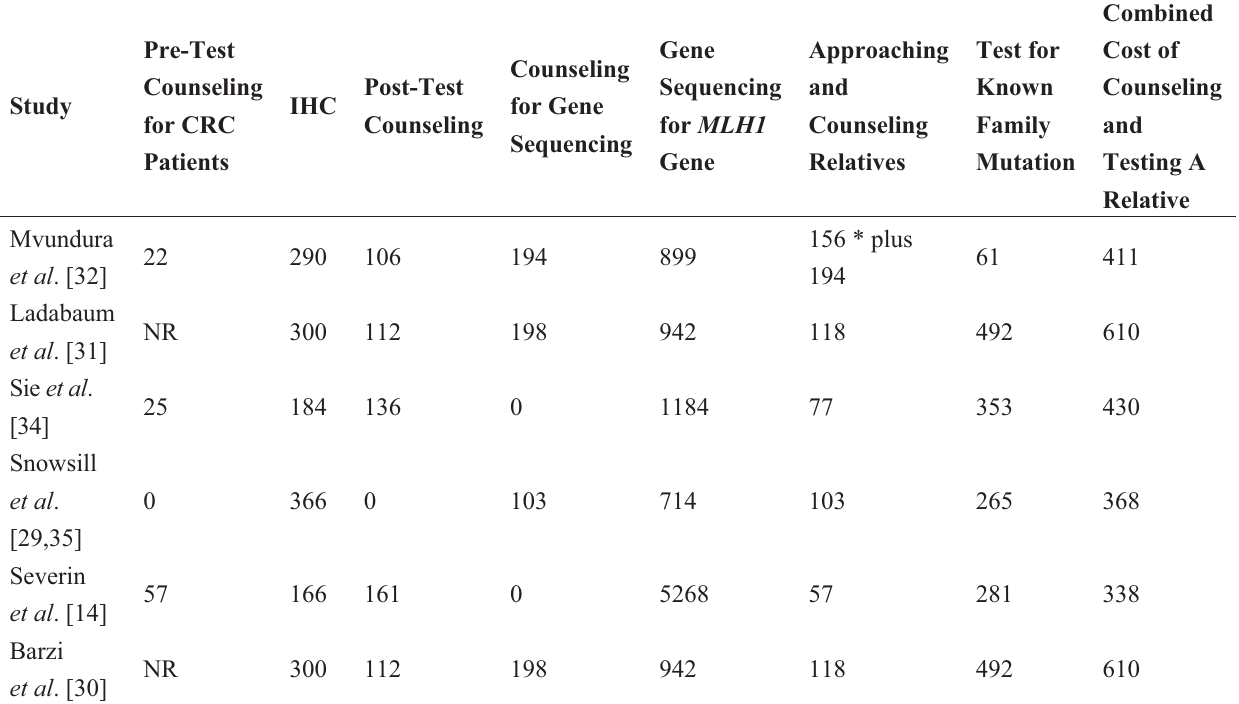
Table 3. Base case values of cost assumptions of routine testing for Lynch Syndrome in patients with colorectal cancer (CRC) and first-degree relatives, in 2014 US